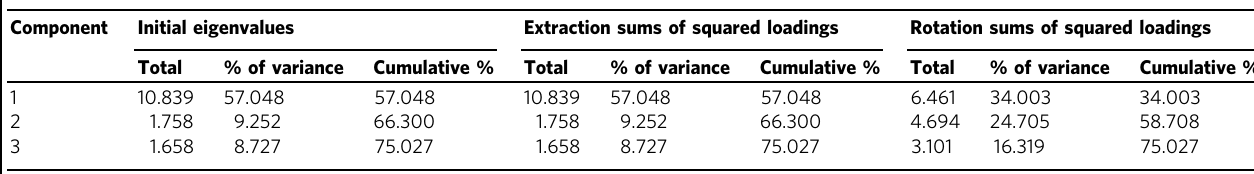
Table 9 The components and total variance explained of output QA for teaching and learning construct. Total variance explained Component